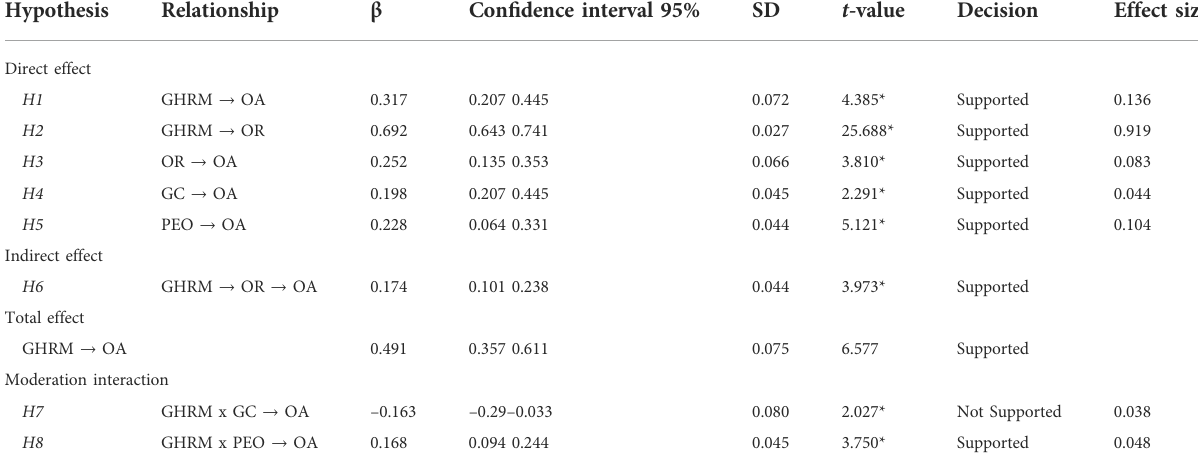
TABLE 4 Hypotheses testing and strength of the model.